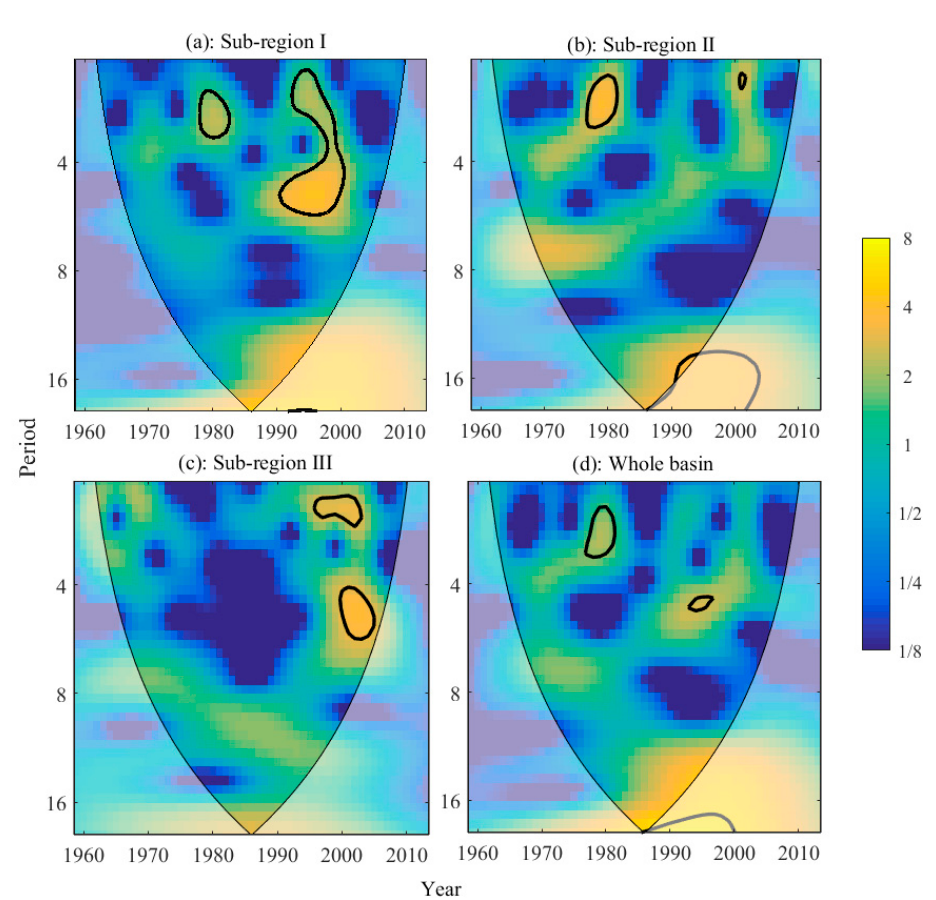
Figure 7. The continuous wavelet power spectrum of summer precipitation of sub-regions and the whole basin. The thick black contour designates the 95% significance level against red noise and the cone of influence (COI) where edge effects might distort the picture is shown as a lighter shade. Figures for ( a – d ) represent continuous wavelet power spectrum for sub-region I, sub-region II, sub-region III and the whole basin respectively.